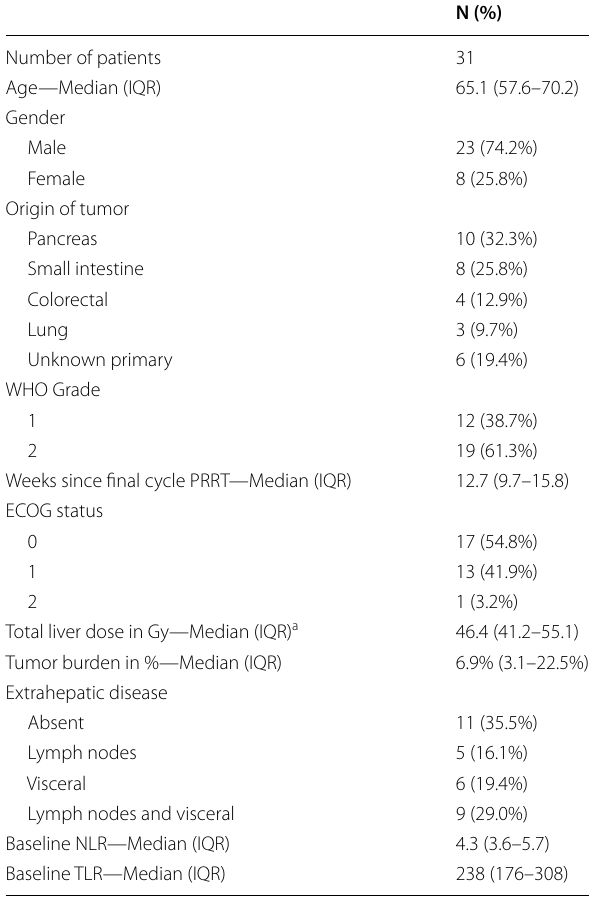
Table 1 Baseline characteristics of included patients in the HEPAR-PLuS trial